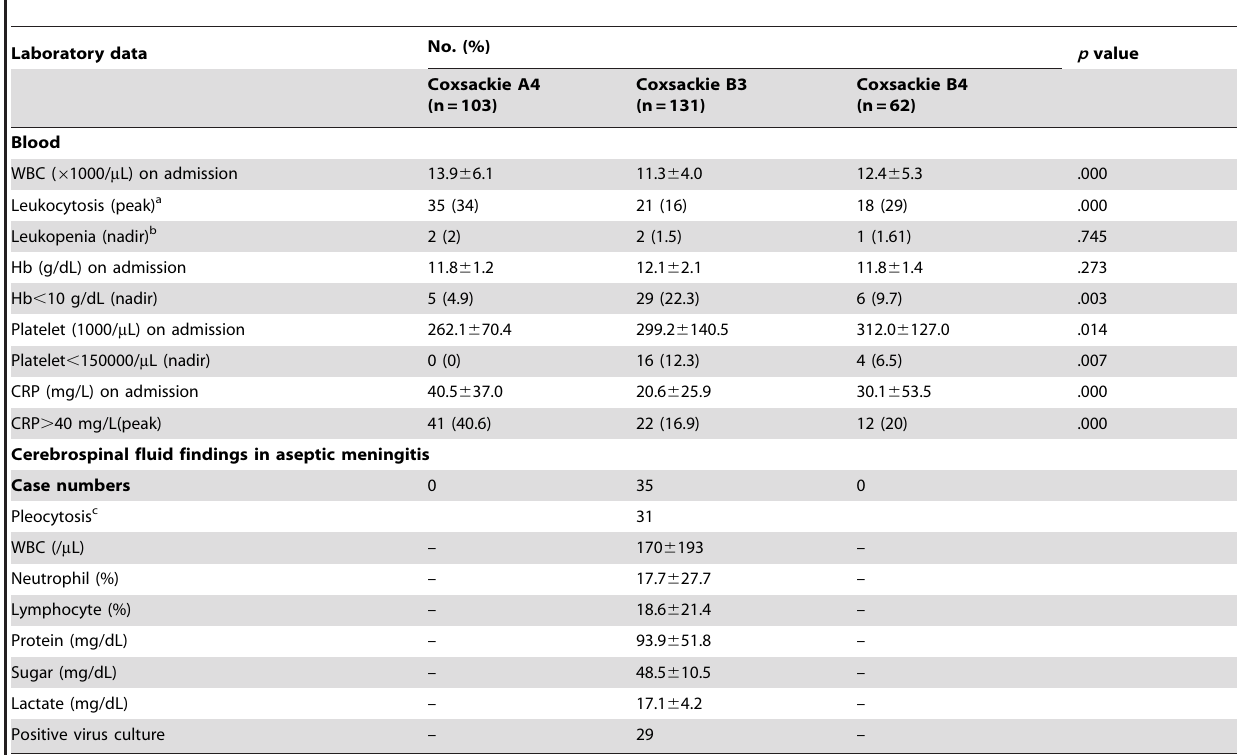
Table 3. Laboratory findings in 296 hospitalized children with Coxsackievirus A4, B3 and B4 infections stratified by serotypes.